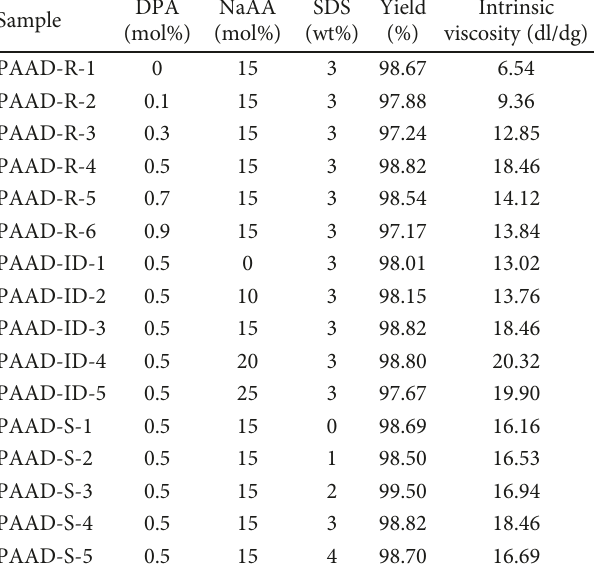
Table 1: Reaction conditions of PAAD.